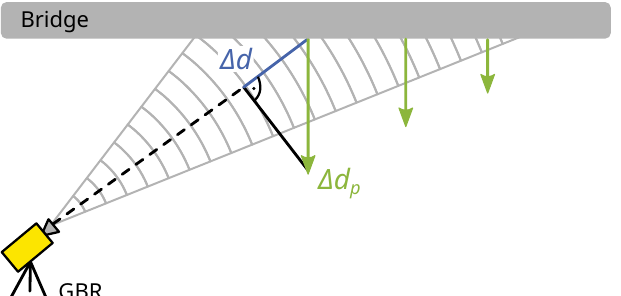
Figure 1. Horizontal view of the measurement principle of GBRs at a bridge underside with LOS- displacement ∆ d and projected displacement ∆ d p